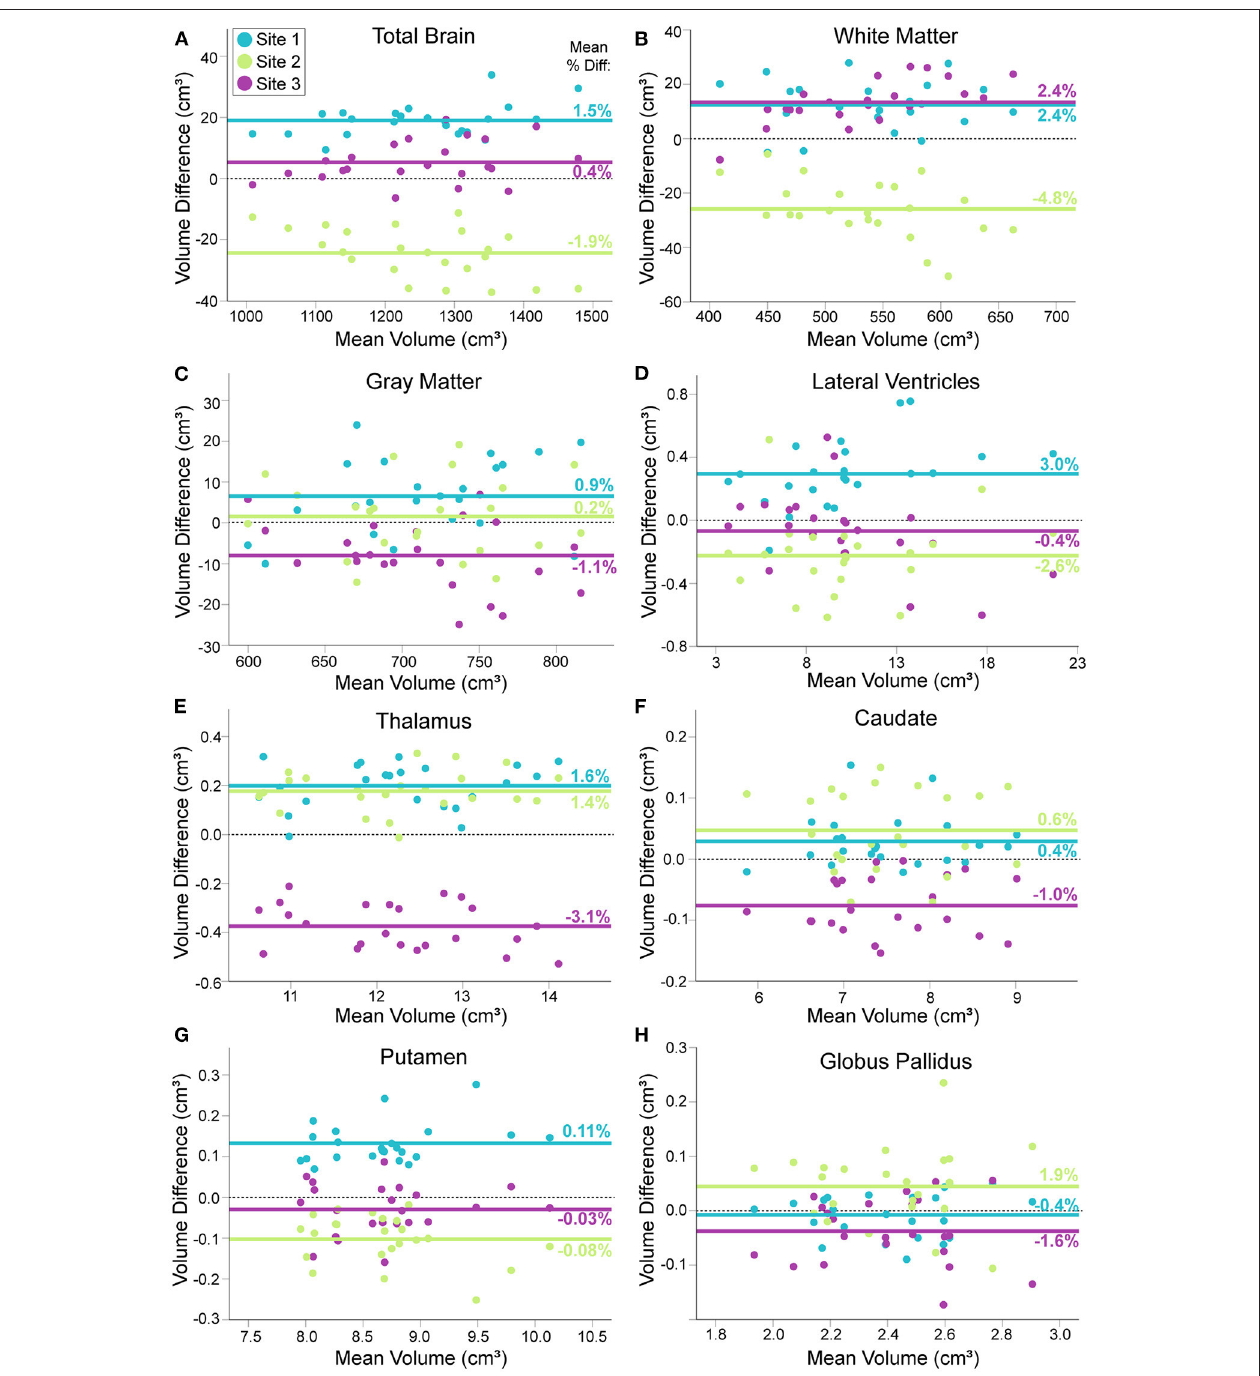
FIGURE 3 | Modified Bland–Altman plots, showing the mean difference between each traveling phantom’s average volume at a given site (two scans) and their individual average across all three sites (Y axis), plotted against their mean volume over all three sites (X axis). For total brain (A) , white matter (B) , gray matter (C) , lateral ventricle (D) , thalamus (E) , caudate (F) , putamen (G) and globus pallidus volumes (H) . Each group of three points per volume (aligned vertically) represents one of the 23 traveling human phantoms. Solid lines indicate the mean volume difference across participants for each site (mean percent difference indicated numerically on each line); dotted black line indicates a mean difference of zero for reference. Some structures show close alignment between two sites [e.g., white matter (B) , thalamus (G) ] while others suggest that one site is close to the grand mean while the other two sites differ [e.g. total brain volume (A) ]. Plots indicate volume difference between sites does not depend on mean volume, with the exception of total brain and white matter volume at Site 2 (ACH), which becomes slightly more different from the total mean at larger volumes.